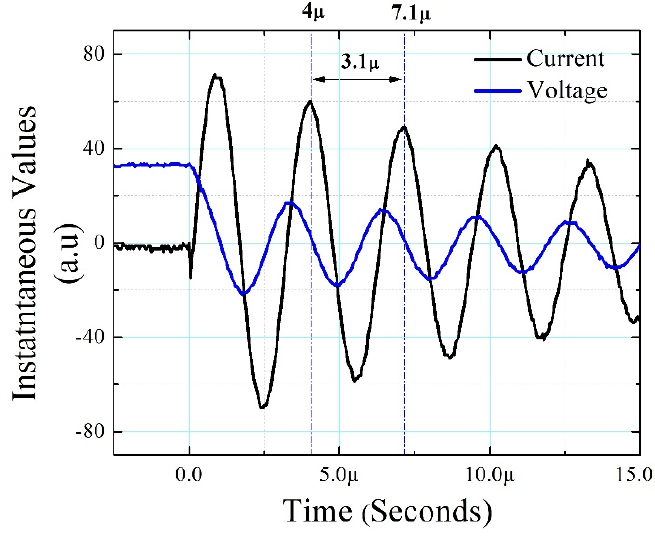
Figure 12. Current and Voltage discharge waveform. The experimental results obtained for Plane Parallel and Hemi-sphere electrode pro- files are shown in Figure 13a,b.